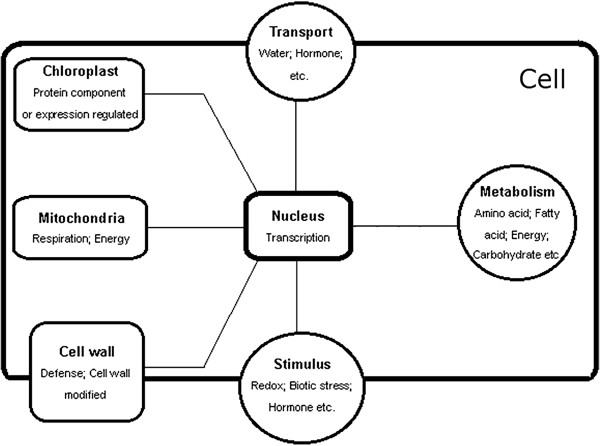
A diagram of the regulation of photosynthesis by nuclear genes. The diagram depicts the main cell components (in squares) and processes (in circles) that were identified in this study. Annotation reflects the function of the identified genes. This figure is a simple draft, in which the relationship between components and processes is not considered.